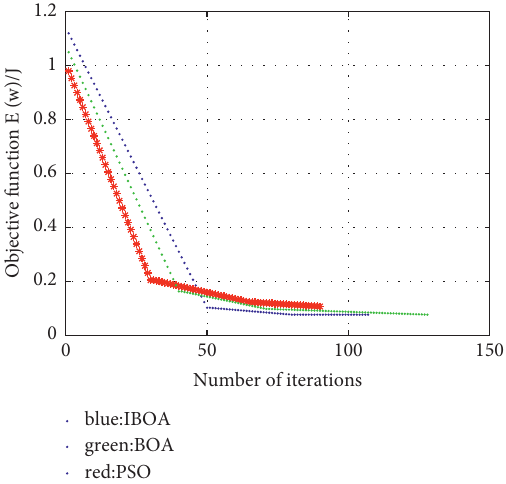
� 0rad. 7 under “--+” working mode and θ